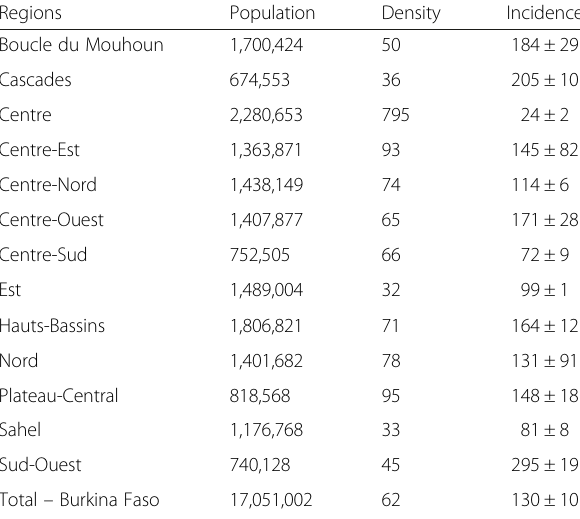
Table 4 Evolution of the number of doses and cost